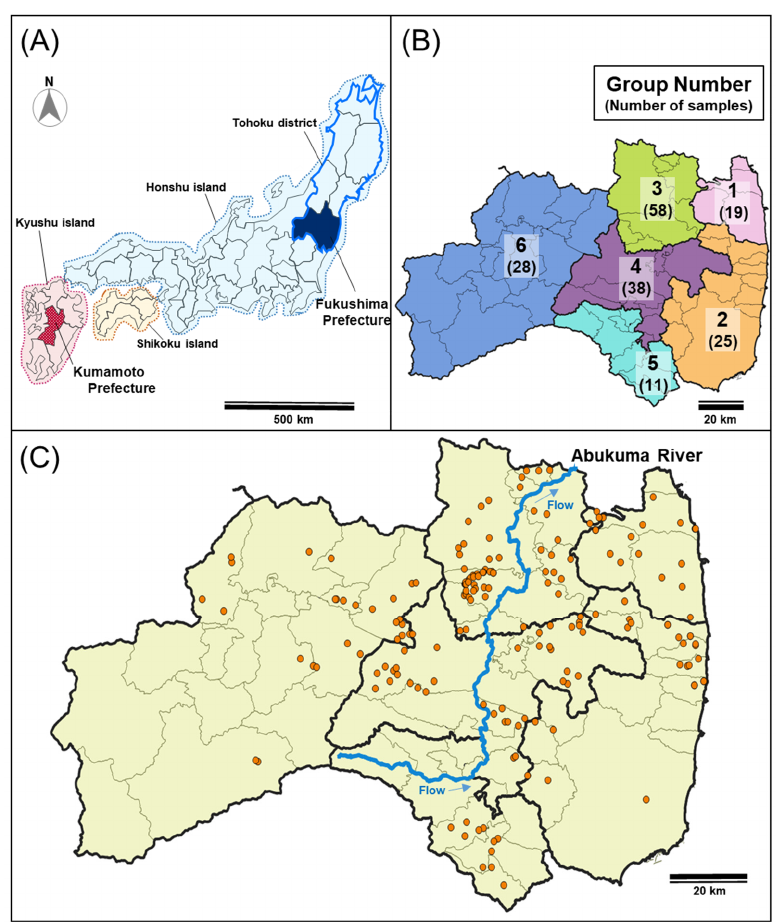
Figure 1. Sampling locations of wild boars. ( A ) Location of Fukushima Prefecture and Kumamoto Prefecture. ( B ) Six regions of Fukushima Prefecture (1, North of Soso; 2, South of Soso and Iwaki; 3, Ken-Poku; 4, Ken-Chu; 5, Ken-Nan; 6, Aizu). Numbers in parentheses represent the number of wild boars analyzed in each district region. ( C ) The sampling location of wild boars in Fukushima Prefecture. Sampling points of wild boars are shown in orange dots. These figures were created using QGIS 3.1.6 (https://www.qgis.org/en/site/, accessed on 15 February 2022). The map of Fukushima Prefecture and Abukuma River were obtained by Ministry of Land, Infrastructure, Transport and Tourism (MLIT) of Japan (http://nlftp.mlit.go.jp/ksj/, accessed on 15 February